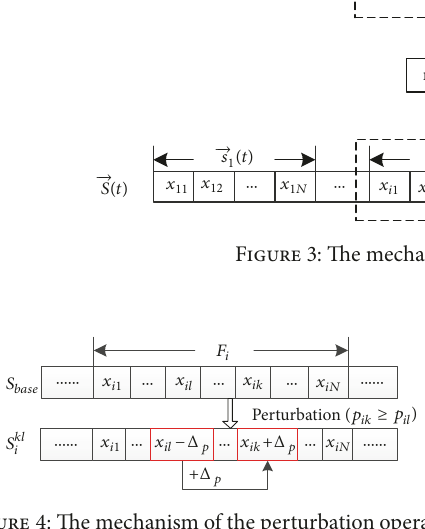
Figure 4: The mechanism of the perturbation